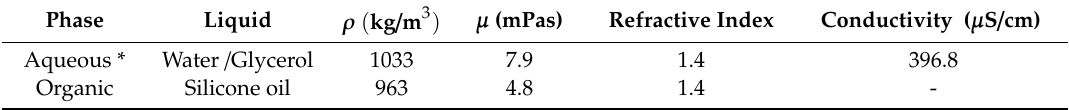
Figure 1. The experiment setup for the inclined liquid-liquid two-phase flows. Table 1. Fluid properties of the liquid-liquid experimental system at 20 ◦